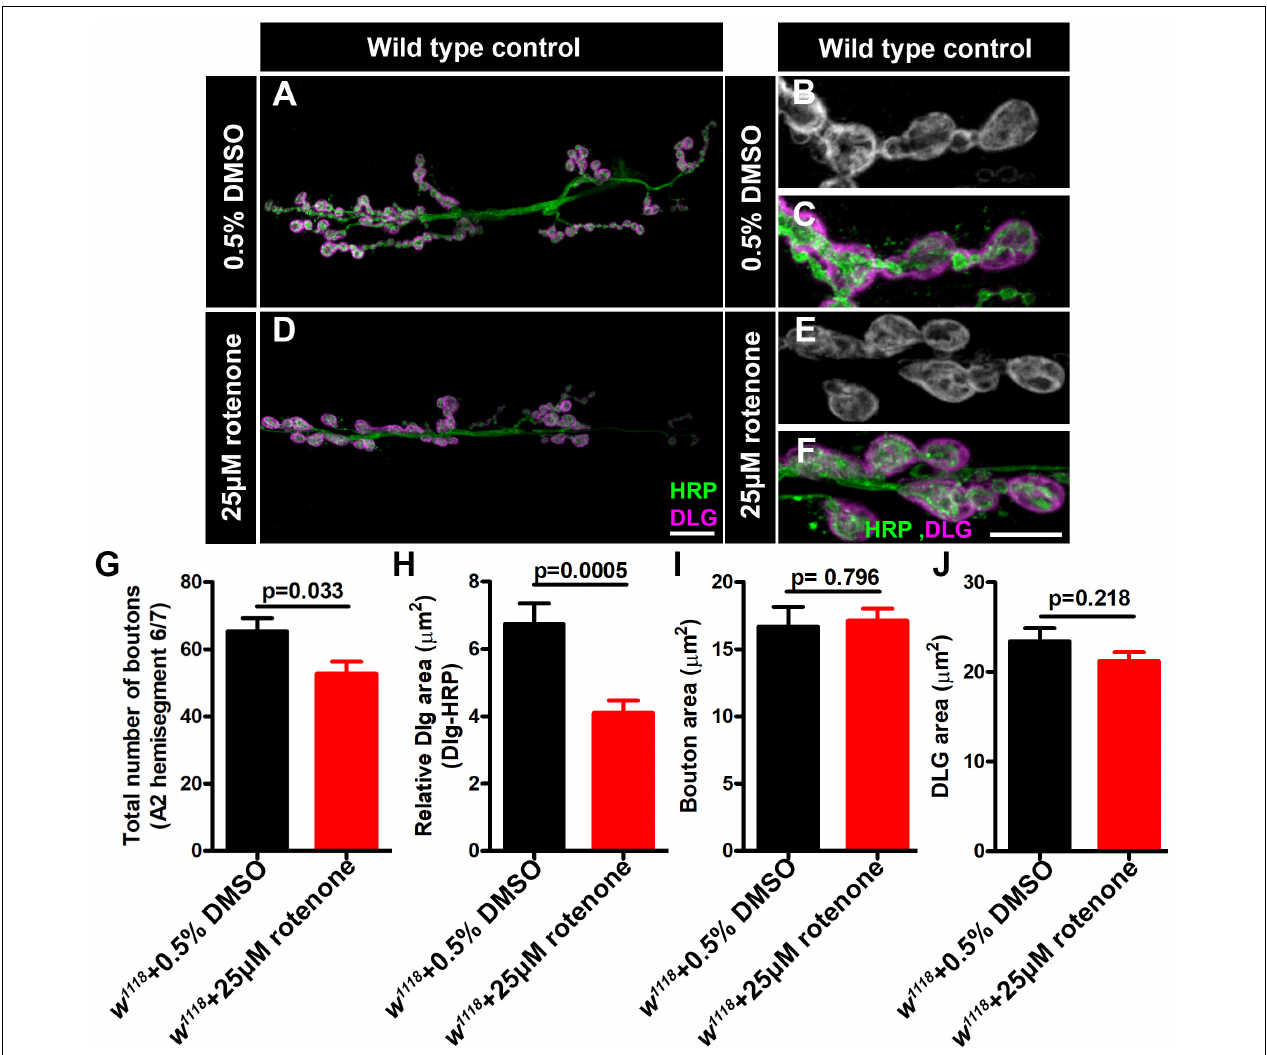
FIGURE 7 | Rotenone affects neuromuscular junction (NMJ) morphology. (A–F) Representative confocal images of NMJ synapses at muscle 6/7 of (A–C) DMSO control, (D–F) Larvae fed with 25 µ M rotenone double immunolabeled with DLG (magenta) and HRP (green) antibodies. The NMJ morphological defects were observed in the indicated genotypes. The flies were reared at 25 ◦ C to conduct NMJ analysis. Scale bar: 10 µ m. (G–J) Histograms showing the average total number of boutons, relative DLG area, bouton area and DLG area at muscle 6/7 of A2 hemisegment in (G) DMSO control (65.25 ± 3.976, N = 8), Larvae fed with 25 µ M rotenone (52.75 ± 3.514, N = 8), (H) DMSO control (6.742 ± 0.6156, N = 30), Larvae fed with 25 µ M rotenone (4.101 ± 0.3706, N = 30), (I) DMSO control (16.67 ± 1.461, N = 30), Larvae fed with 25 µ M rotenone (17.11 ± 0.8969, N = 30) and (J) DMSO control (23.41 ± 1.473, N = 30), Larvae fed with 25 µ M rotenone (21.21 ± 0.9790, N = 30) samples. Rotenone-treated larvae showed reduced boutons number and DLG area at the NMJs. Minimum 35 type-1b boutons from 4 animals (8 muscle 6/7 NMJs of A2 hemisegment) were used for quantification. p-values are indicated in the figure. Statistical analysis based on Student’s t -test for pairwise comparison. Error bars represent mean ±